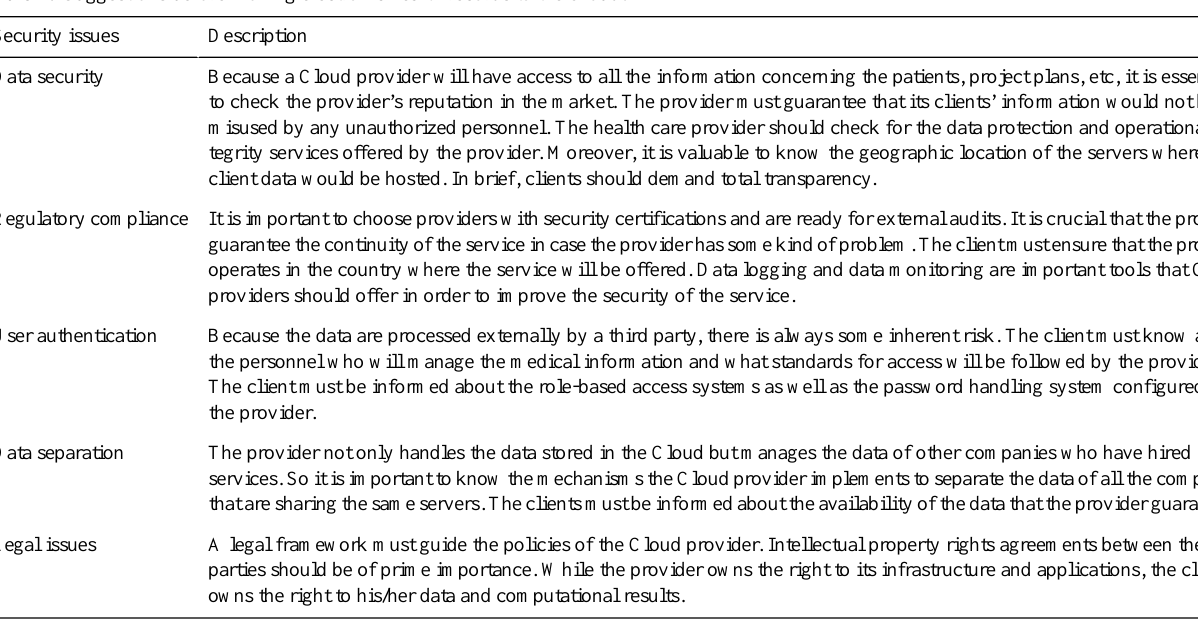
Table 2. Suggestions before moving electronic health records to the Cloud.